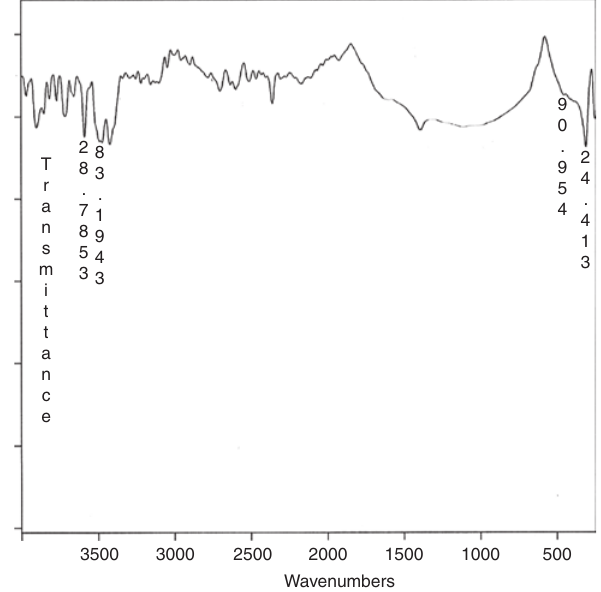
Figure 6: FT-IR spectrum of PbS nanoparticles.